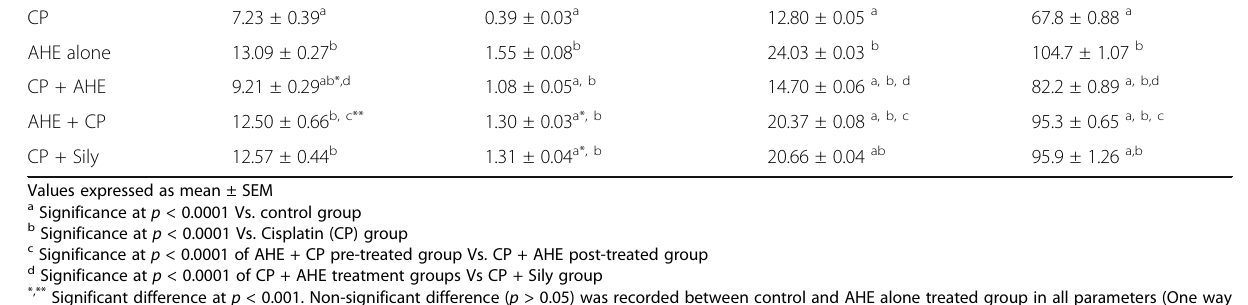
Table 3 Effect of cisplatin (CP) and different treatments of AHE on Phase I antioxidant enzymes Group POD (U/min) SOD (U/mg protein) CAT (U/min) QR (nM/min/mg protein) Control 13.40 ± 0.23 b